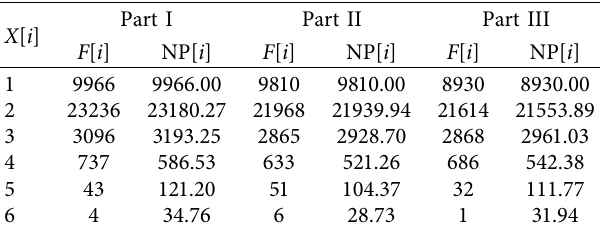
Table 4: Fitting extended logarithmic to static word-length dis- tribution data of the three parts of